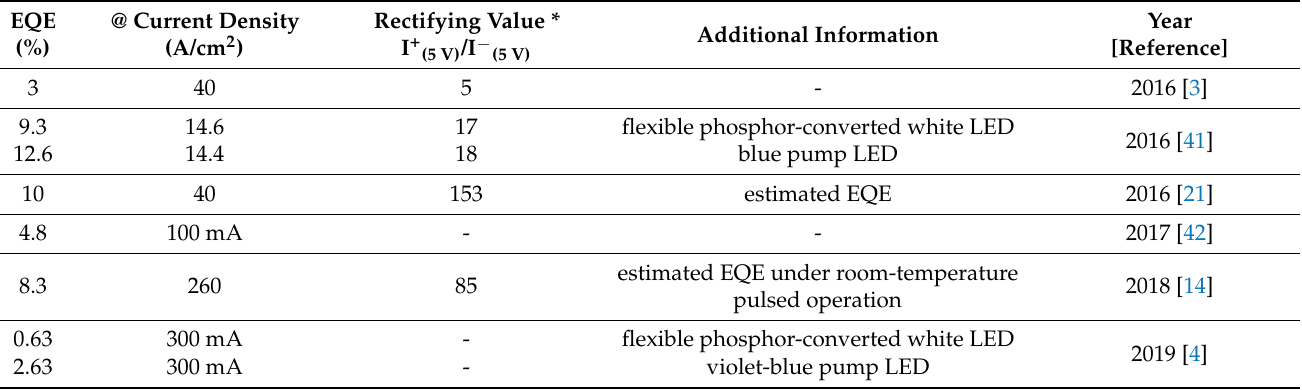
Table 1. Comparison of electro-optical characteristics (EQE, rectifying value I + (5 V) /I − (5 V) ) for a given current density (for a given current) from InGaN/GaN core–shell microrod